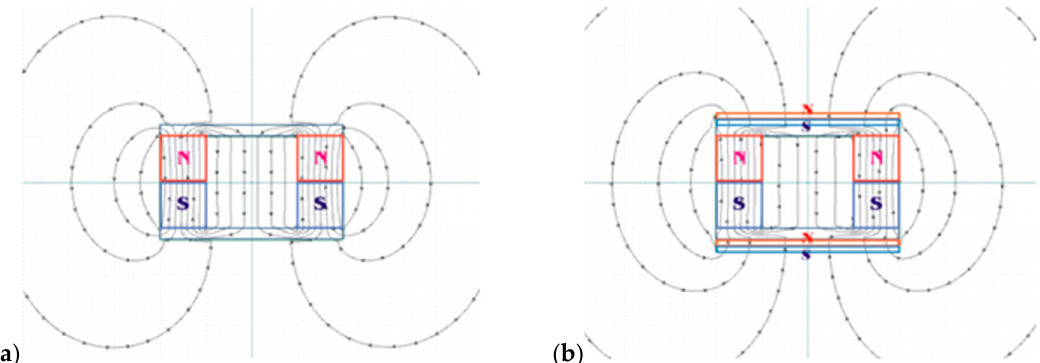
Figure 2. The magnetic field directions of the first device ( a ) and additional magnets at the top and bottom parallel to the existing magnets ( b ).